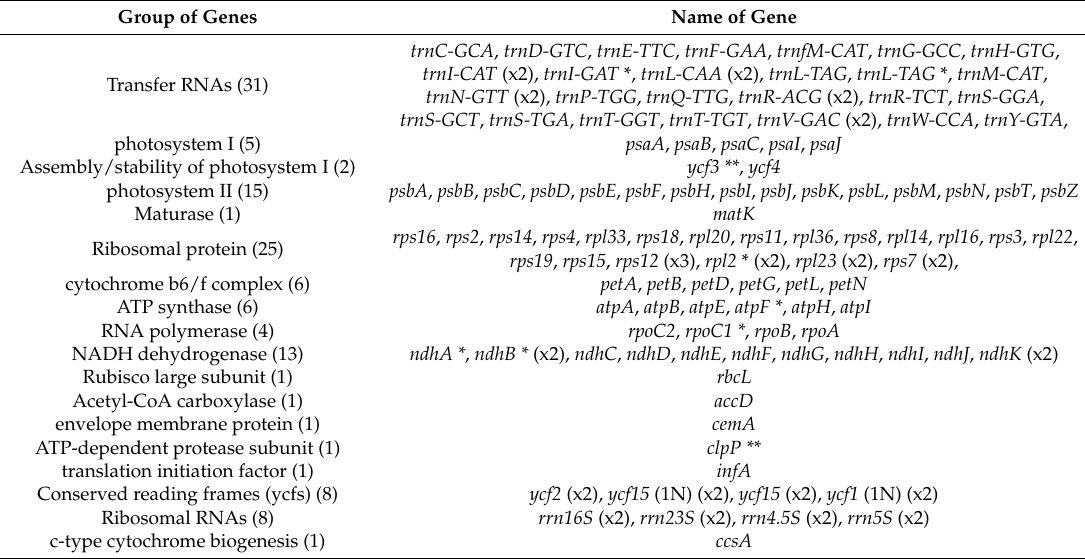
Table 2. A list of genes found in the chloroplast genomes of the three Rheum species including copy number and introns